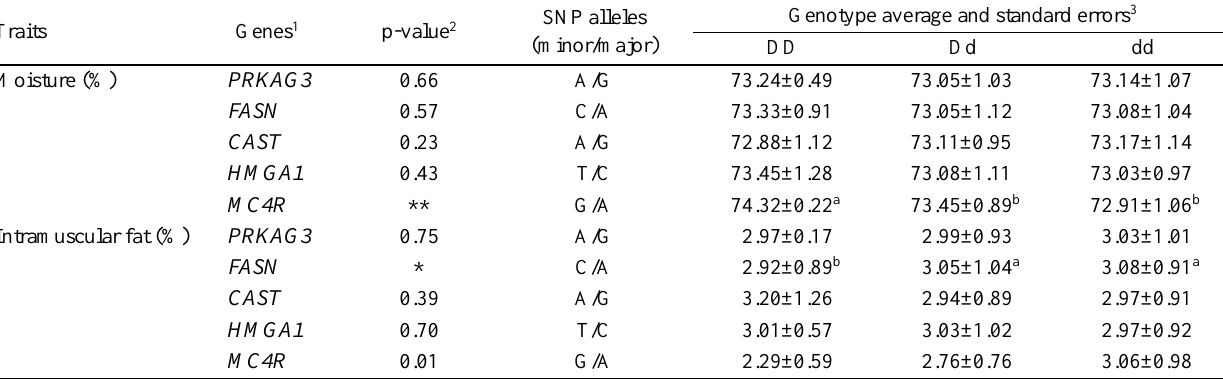
Table 4. Association of SNP genotypes and their harboring genes with chemical composition of LD muscle in Duroc breeding stock